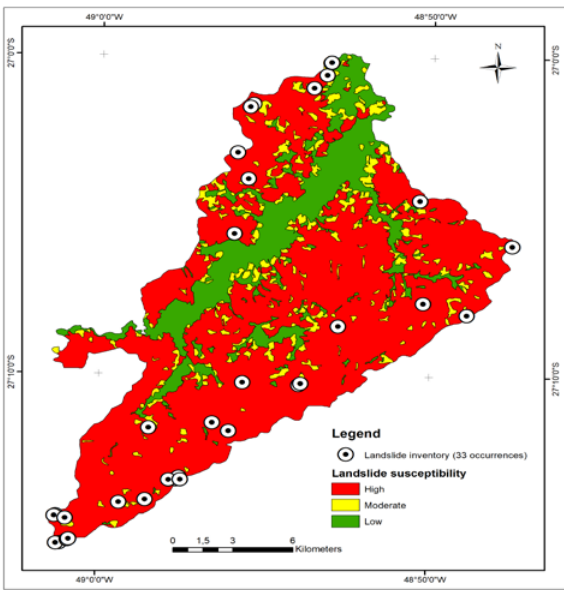
Figure 4. Landslide inventory map for the Brusque city showing the location of 500 landslides identified in remote sensors products acquired in 2010. The purple polygons indicate the location of landslides of the 5A, 5B and 5C figures.